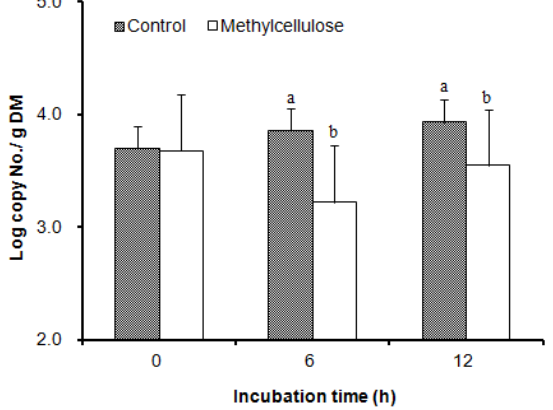
Figure 9. DM digestibility of rice straw as influenced by pre- treatment with MC (methylcellulose). a,b Means with different letters differ significantly